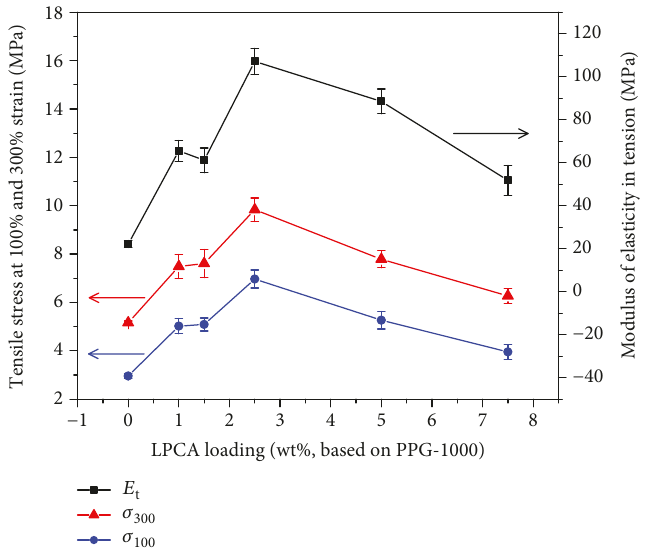
Figure 4: E ff ect of LPCA loading on tensile stress at 100% strain ( σ tension ( E ). t